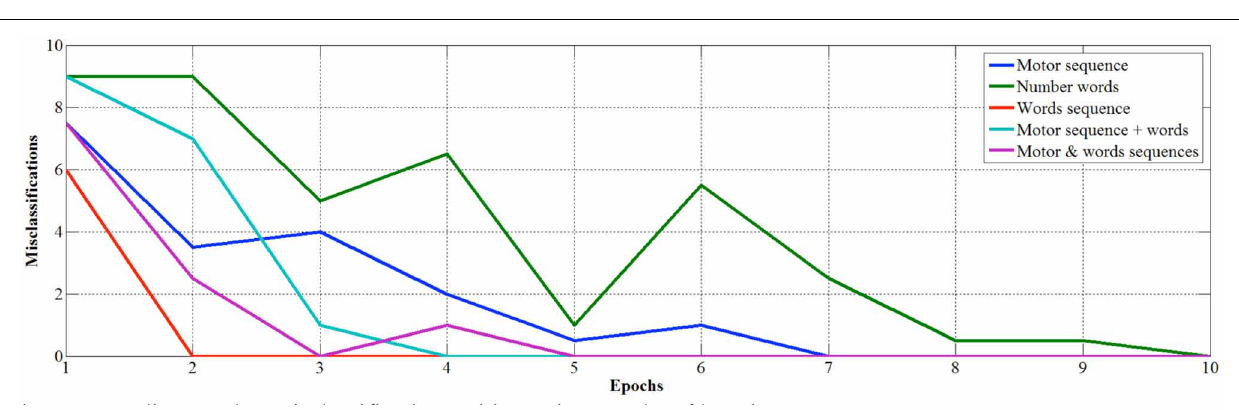
FIGURE 7 | Median number misclassifications with varying epochs of